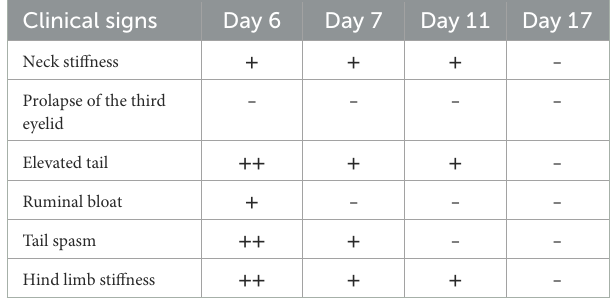
TABLE 3 Changes in the clinical symptoms observed during the treatment of patient with